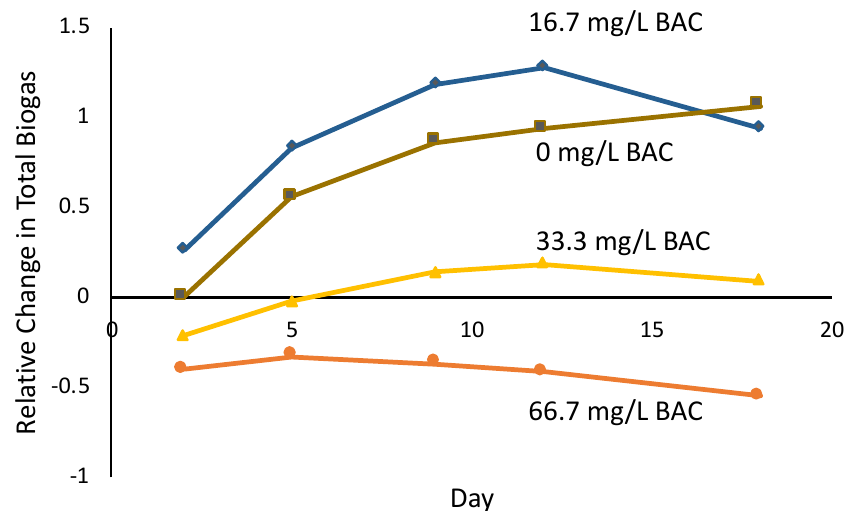
Figure 9. The change in combined CH 4 and CO 2 in the microcosm headspace after exposure to BAC relative to the 0 mg/L microcosm on day 2.